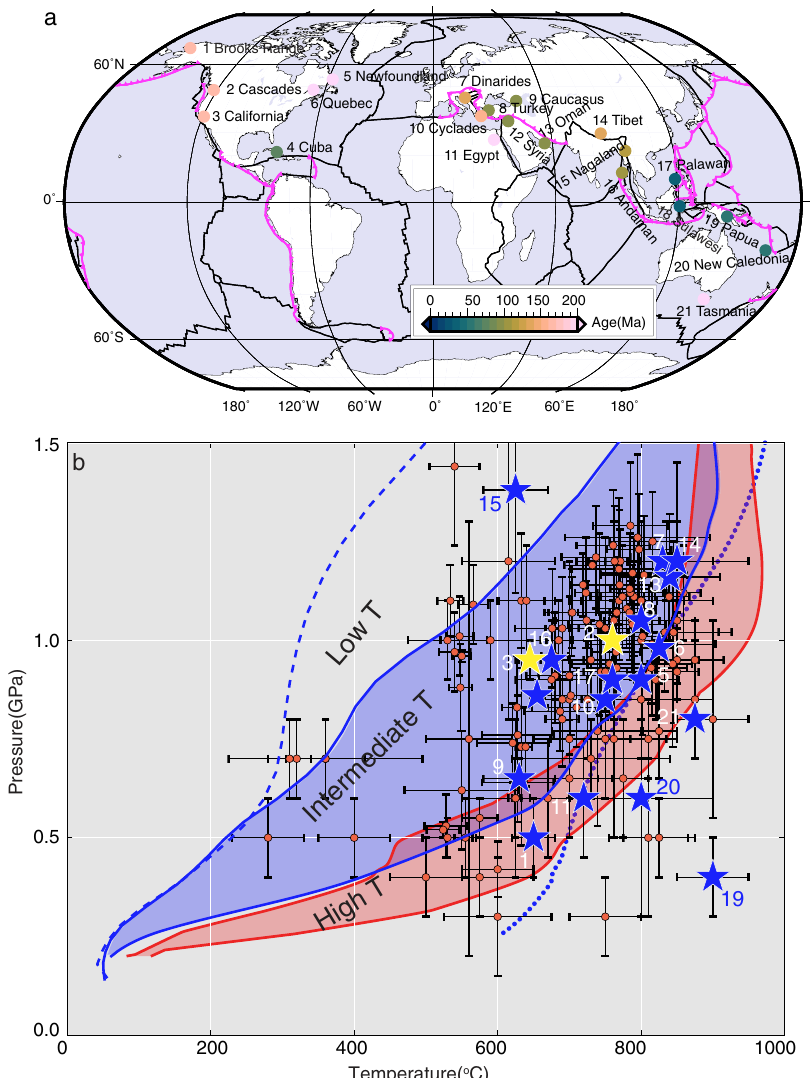
Fig. 2 Distribution and thermobarometry data of metamorphic soles. a Localities of metamorphic soles (colored circles, updated from ref. 30 ) and b their pressure – temperature conditions (red circles). The color of the circles in a indicates the age of the metamorphic soles, which is interpreted to be equivalent to the approximated timing of subduction initiation. In b , blue and yellow stars indicate the peak T condition for a given locality that is likely to have experienced SI in intra-oceanic and passive margin settings, respectively. The black error bars indicate the pressure and temperature evaluation errors. Red region (high-temperature region) outlined by red solid lines indicates the ranges of PT paths predicted by our SSI models with 1 – 20 Ma overriding plate, and blue region (intermediate temperature region) outlined by blue solid lines indicate the ranges of PT paths predicted by our ISI models with 1 – 5 Ma overriding plate. Dotted and dashed blue line indicates the PT paths of an ISI model with a 0 and 40 Ma overriding plate, respectively. The numbers